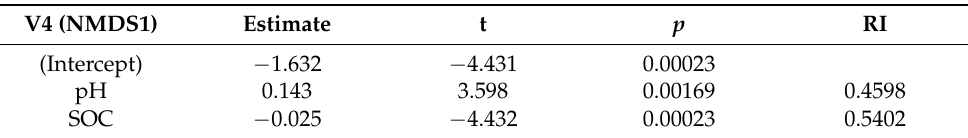
Table 3. The impacts of environmental factors on the soil bacterial community structure of the sequences obtained using the 520f/802r primer set targeting the V4 region.